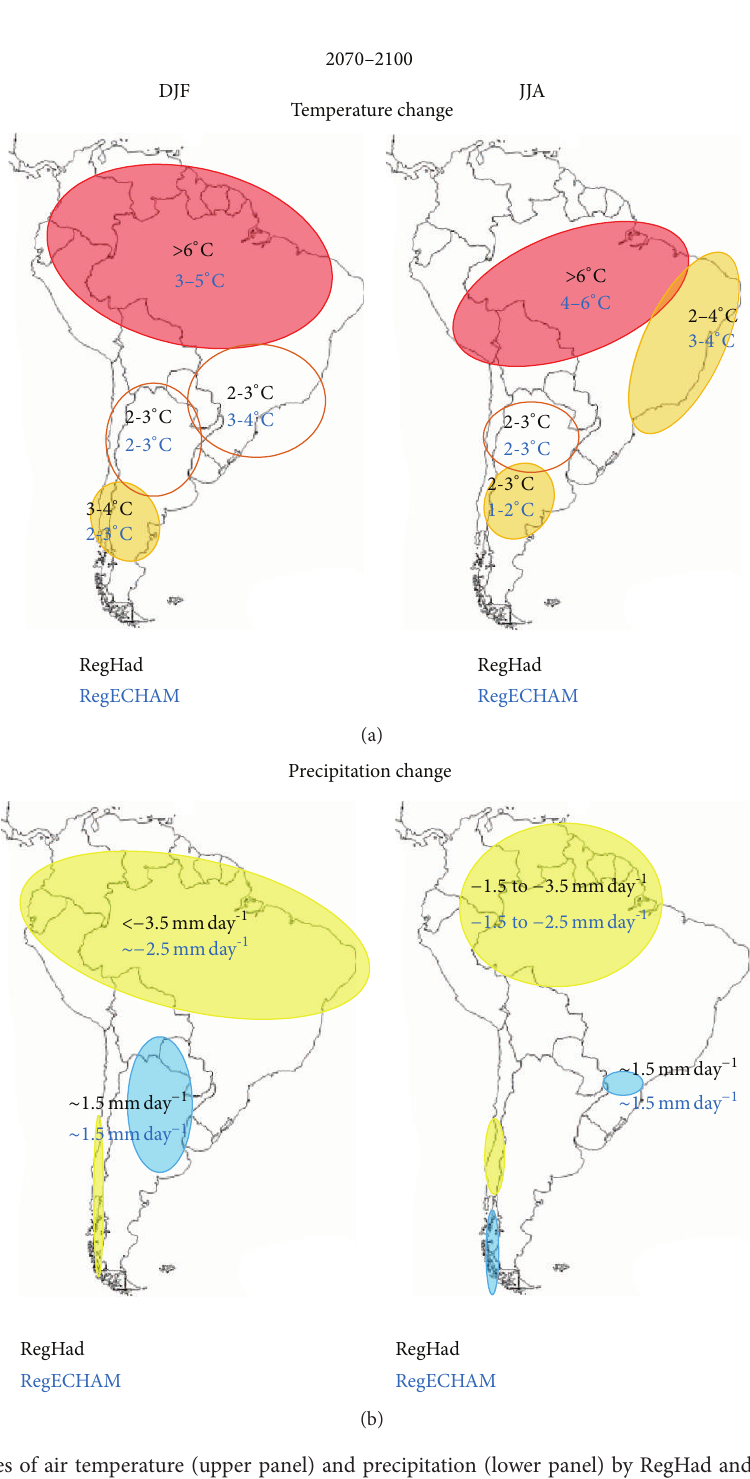
Figure 9: Projected changes of air temperature (upper panel) and precipitation (lower panel) by RegHad and RegECHAM for far-future (2070–2100 minus 1960–1990) climate for the A1B scenario from IPCC. Values in black (blue) represent RegHad